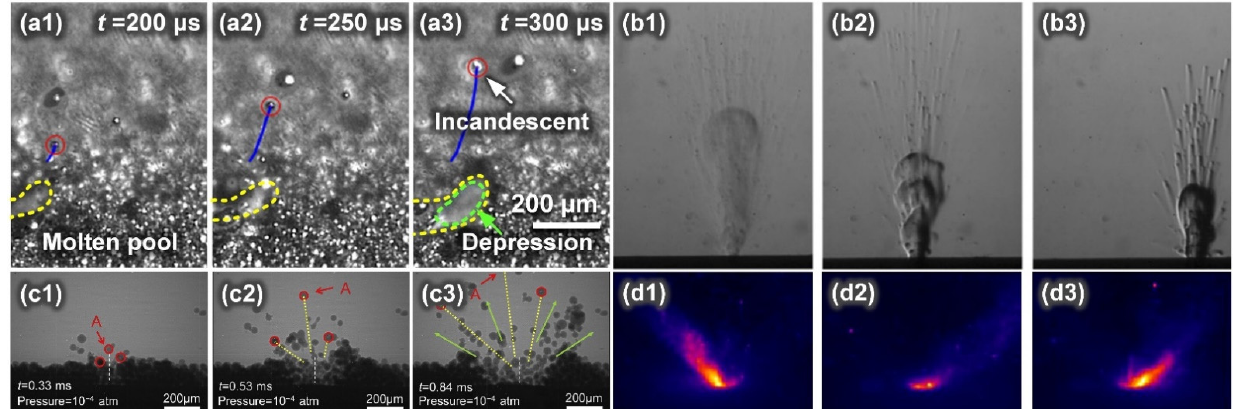
Figure 3. Characteristics obtained from different in situ detection techniques: ( a1 – a3 ) time series snapshots taken by visible light high-speed camera (Reprinted with permission from Ref. [34]. Copyright 2019 Elsevier B.V.); ( b1 – b3 ) high-speed schlieren images during single track scans (Reprinted with permission from Ref. [35]. Copyright 2018 Springer Nature.); ( c1 – c3 ) dynamic X-ray images showing powder motion, A is the ejected powder (Reprinted with permission from Ref. [36]. Cop-